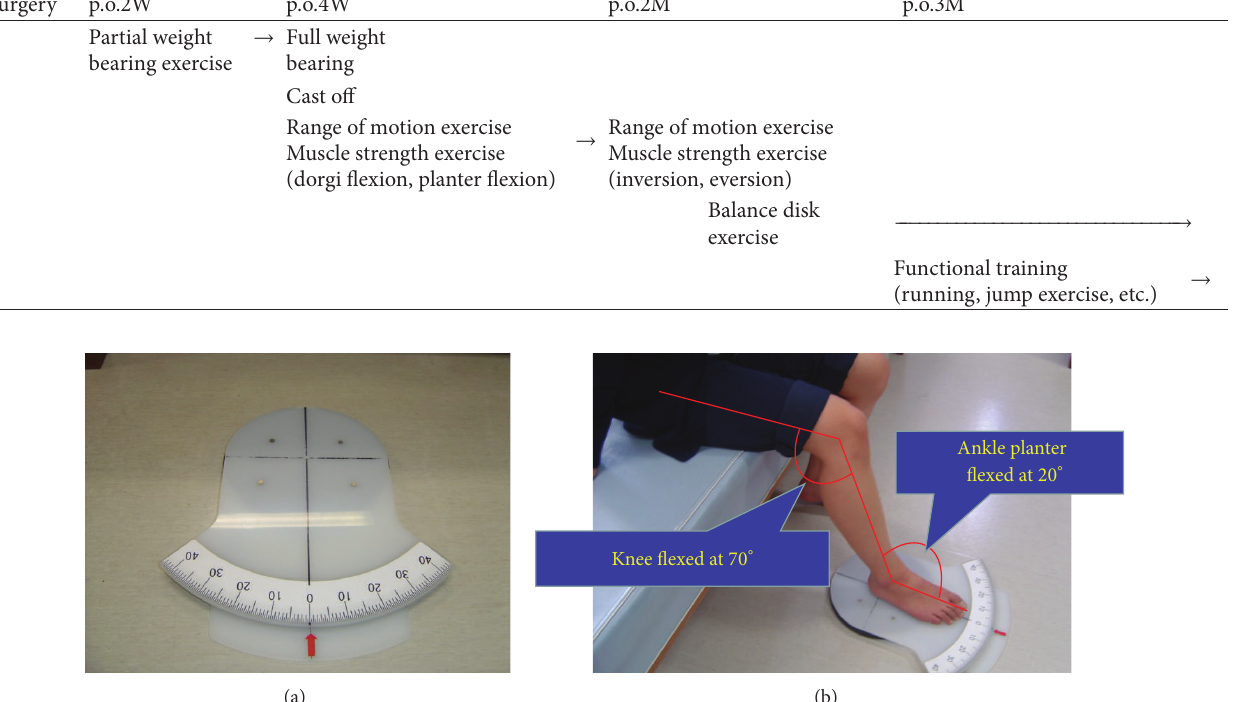
Figure 2: Goniometer footplate (a) and angles for the measurement of joint position sense